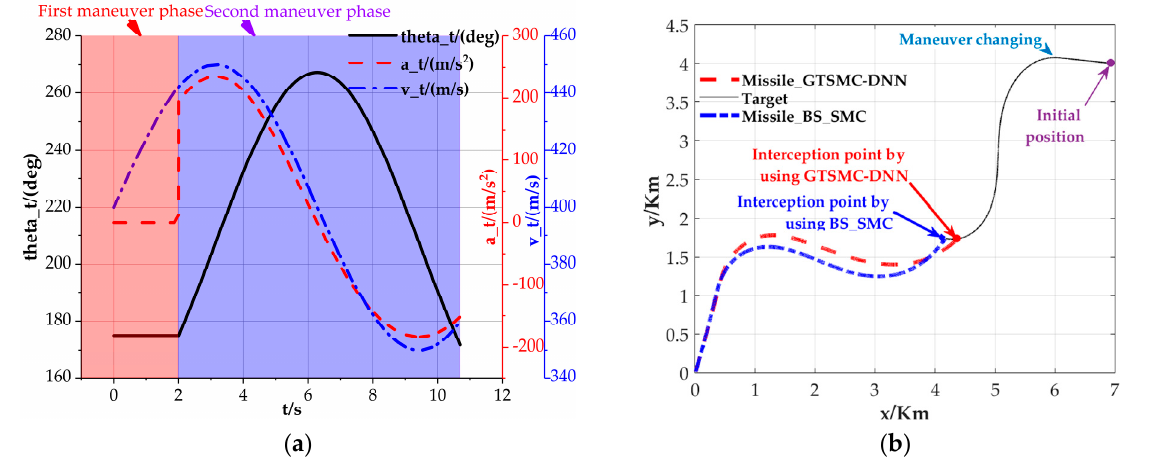
Figure 13. ( a ) The maneuver characteristics of the target; ( b ) The missile–target pursuit trajectory.